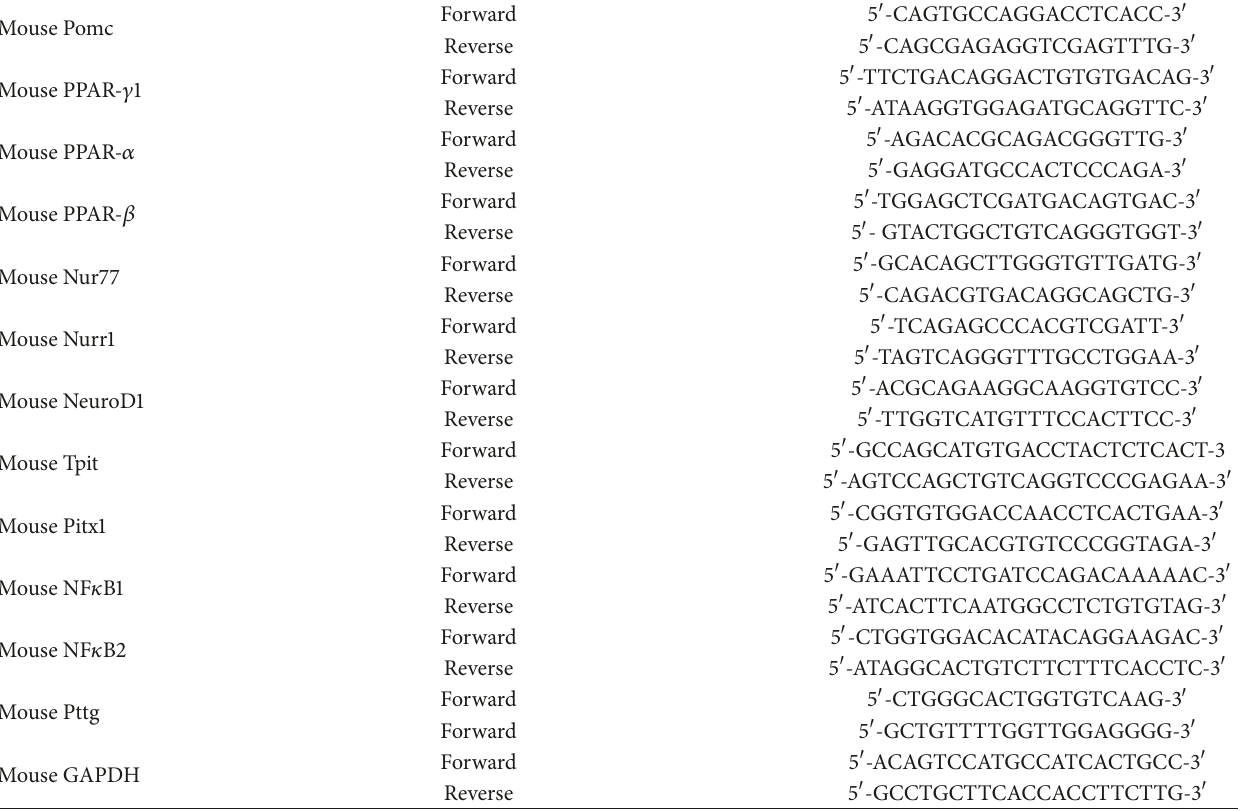
Table 1: Primer sequences for